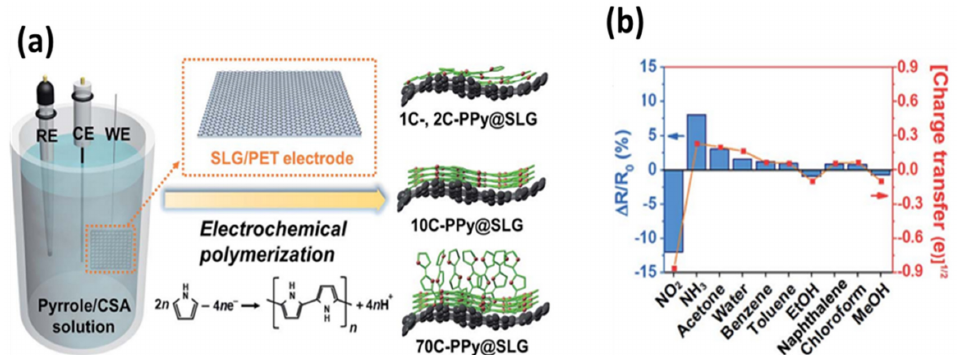
Figure 12. ( a ) Synthesis of polypyrrole (PPy) on a single-layer graphene/polyethylene terephthalate (SLG/PET) film using a three-electrode system and representation of the electrochemical polymeriza- tion and structure after the application of 1, 10, and 70 cycles to the nanocomposite. ( b ) Assessment of the sensor selectivity for several gases at a concentration of 1 ppm. Adapted from [96], copyright 2018, Royal Society of